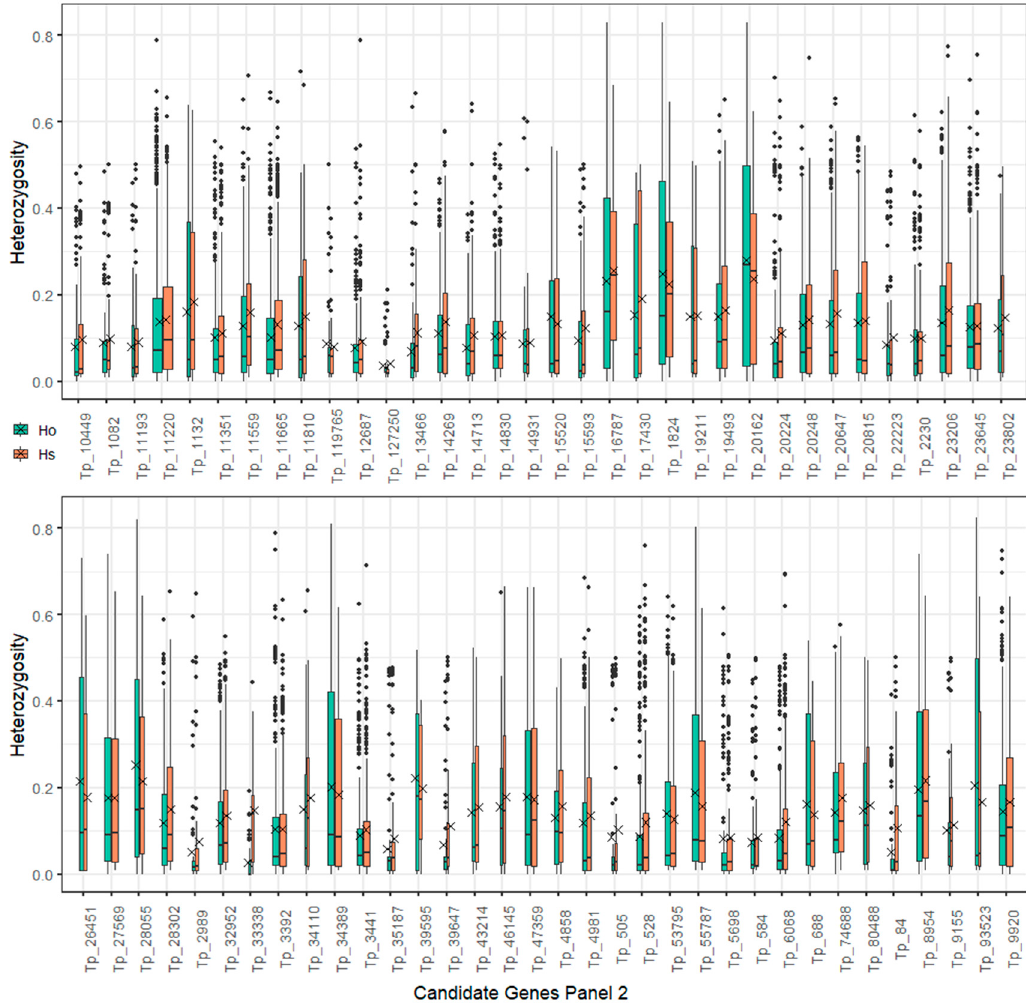
Figure 5. Boxplot of observed (Ho; blue boxes) and expected (Hs; orange boxes) heterozygosity of Panel 2 nitrogen fixation candidate genes. Hs expresses the level of genetic variability. Crosses indicate mean values. Horizontal lines in boxes indicate medians. Bottoms and tops of boxes indicate first and third quartiles of the dataset. Whiskers indicate range of data but the maximum length of each is 1.5 times greater than the height of its box. Remaining points are outliers. The boxes are drawn with widths proportional to the square roots of the numbers of polymorphisms in targeted sequences.